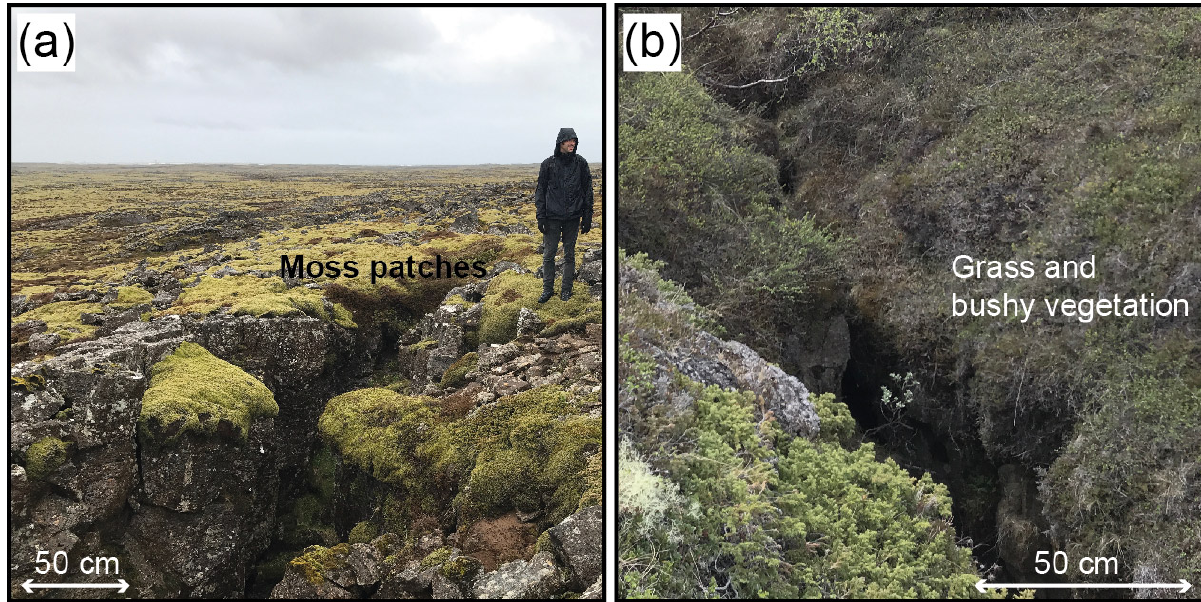
Figure 5. (a) Moss patches have grown over the edges of the fractures, reducing the visible opening locally by the thickness of the moss patch (front) and also completely as visible left of the person; 63 ◦ 54 (cid:48) 27 (cid:48)(cid:48) N, 22 ◦ 33 (cid:48) 41 (cid:48)(cid:48) W. (b) Grass and bushy vegetation can also cover the edges of fractures in areas with soil on top of the bedrock, reducing the visible opening width when viewed from top and impair a clear line of sight from an UAV; 66 ◦ 1 (cid:48) 24 (cid:48)(cid:48) N, 16 ◦ 35 (cid:48) 13 (cid:48)(cid:48) W.